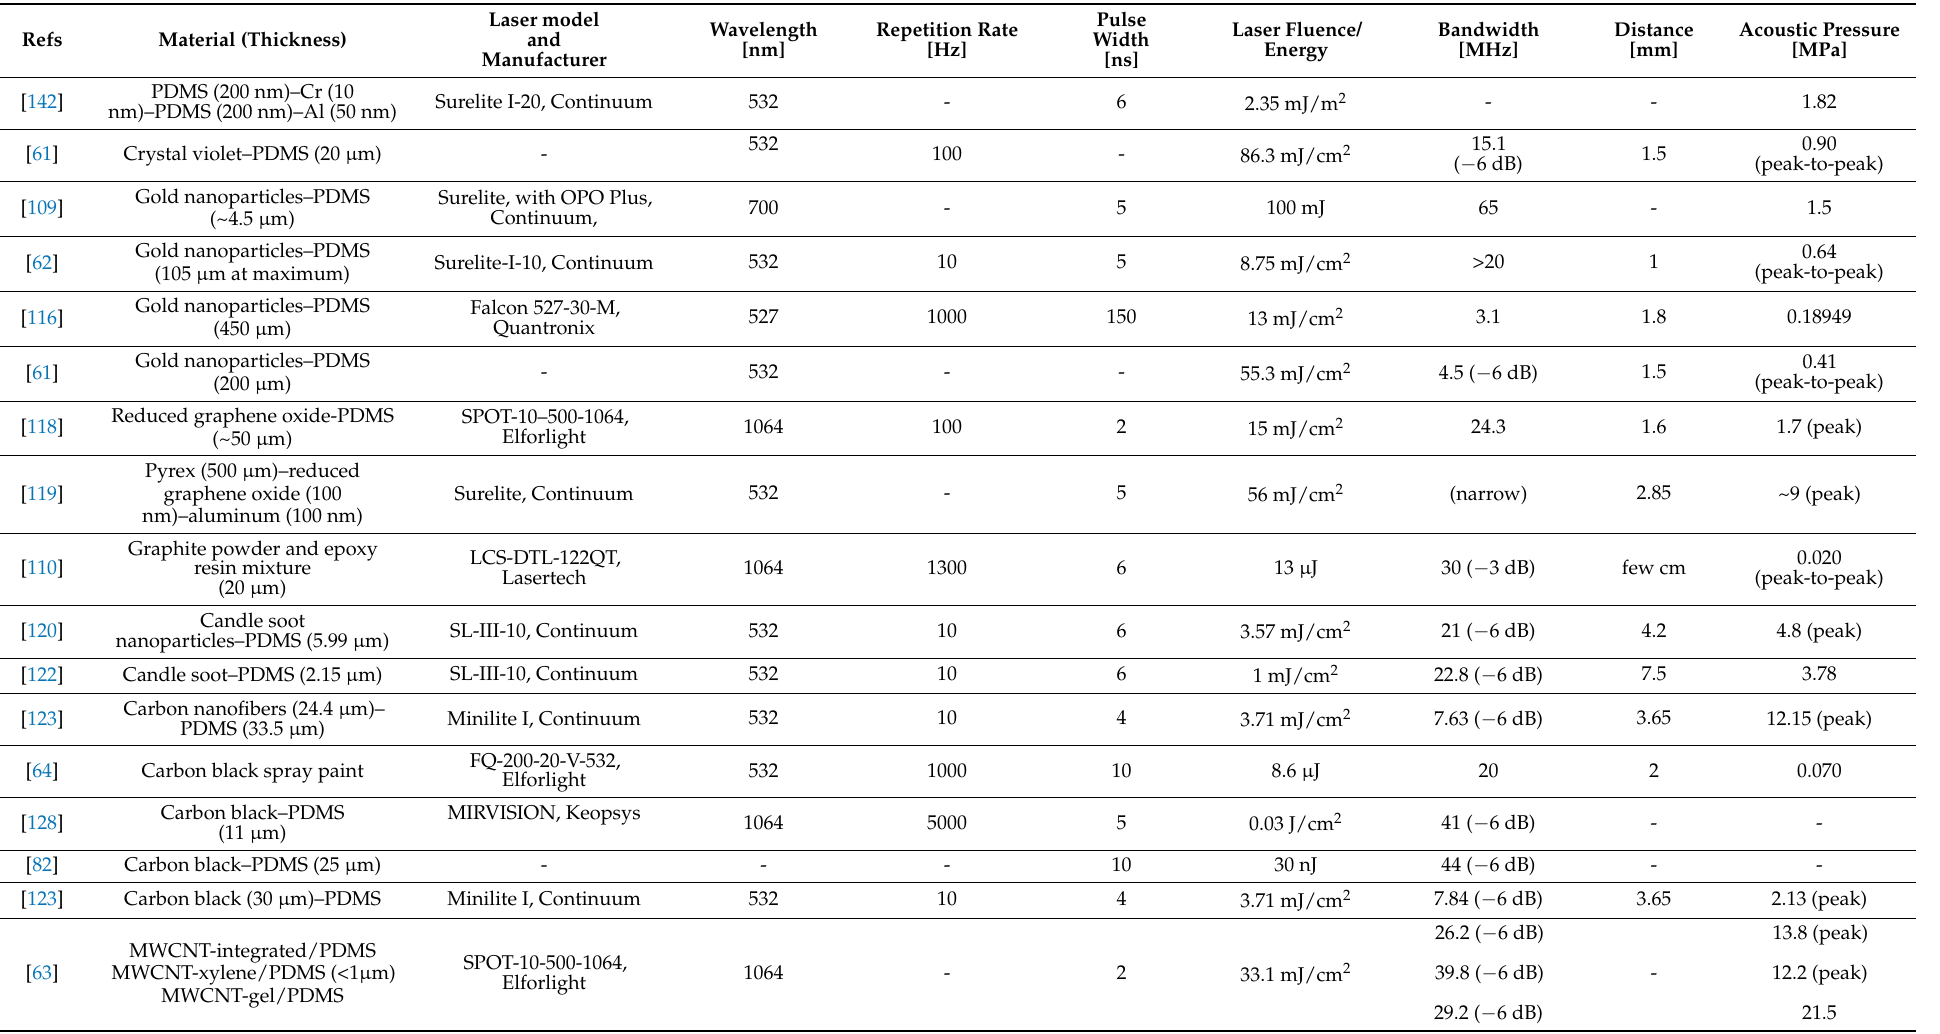
Table 1. Summary of the laser properties employed in photoacoustic systems, including different materials and the consequent US